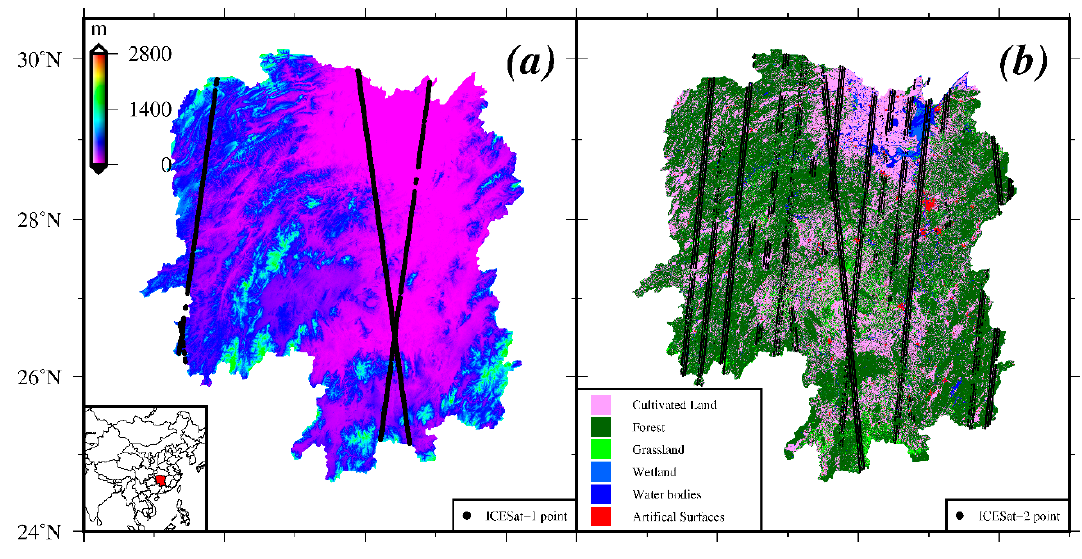
Figure 1. ( a ) Digital elevation map and the filtered footprints of Ice, Cloud, and land Elevation Satellite-1 (ICESat-1) reference data points (black points). ( b ) The map of land cover types and the footprints of the selected Ice, Cloud, and land Elevation Satellite-2 (ICESat-2) altimetry data (black points).